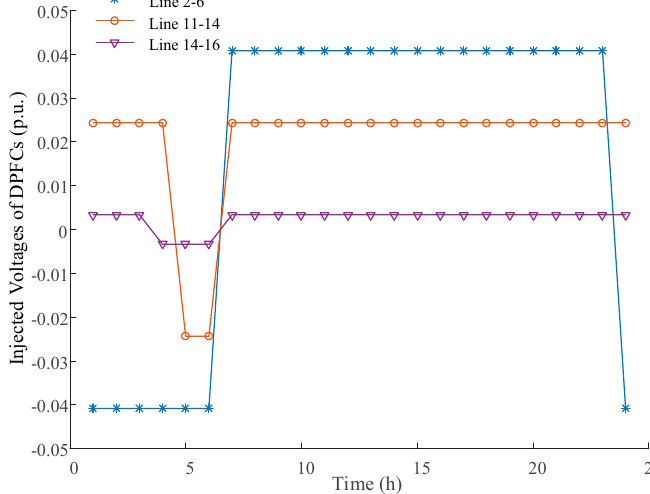
Figure 11. Optimal control strategy of DPFCs in real-time scheduling stage.